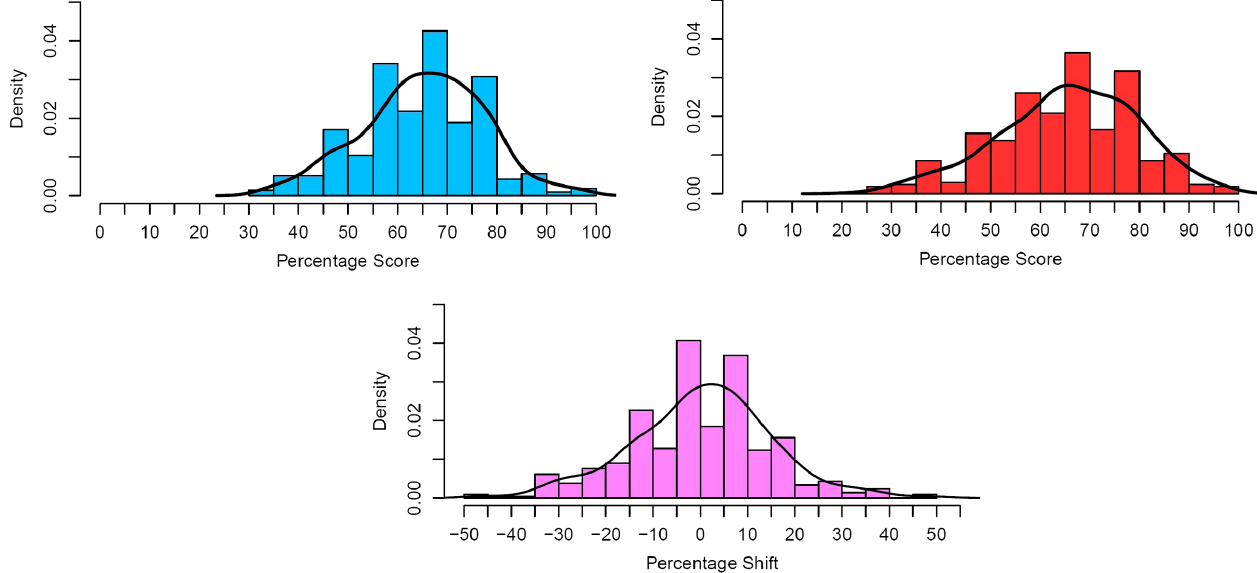
histogram.FIG. 6. Distributions of factor scores and shifts for personal connections to physics . Top row shows score distributions for pre (left) and post (right) responses, bottom row shows the distribution of score shifts. The bolded line represents the density curve for each